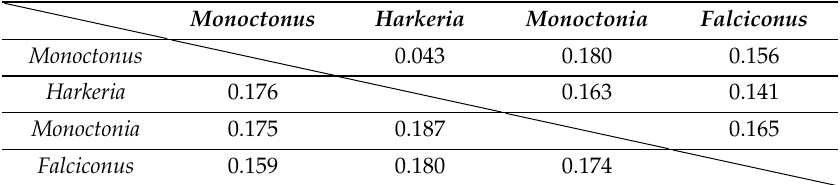
Table 2. Ge netic distances between genera of Monoctonina based on COI sequences (below Table 2. Genetic distances between genera of Monoctonina based on COI sequences (below diagonal) diagonal) and 28S rDNA sequences (above diagonal). and 28S rDNA sequences (above diagonal).